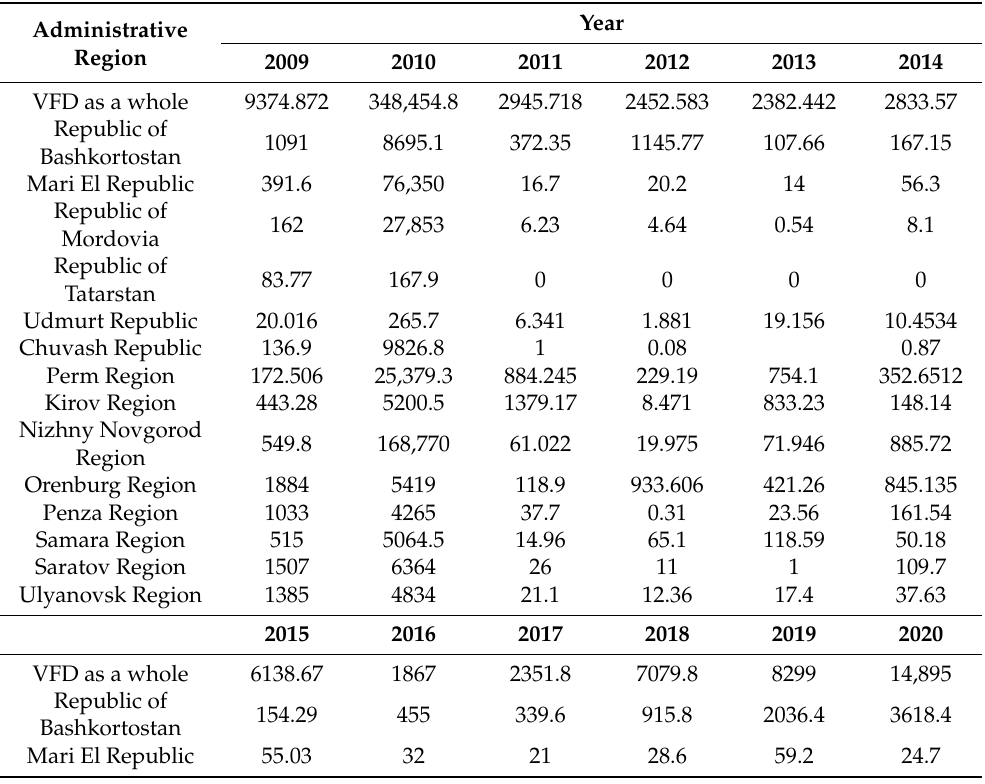
Table 3. Forest cover area with fires (ha) by the administrative regions of the Volga Federal District (VFD) (see Figure 1) during